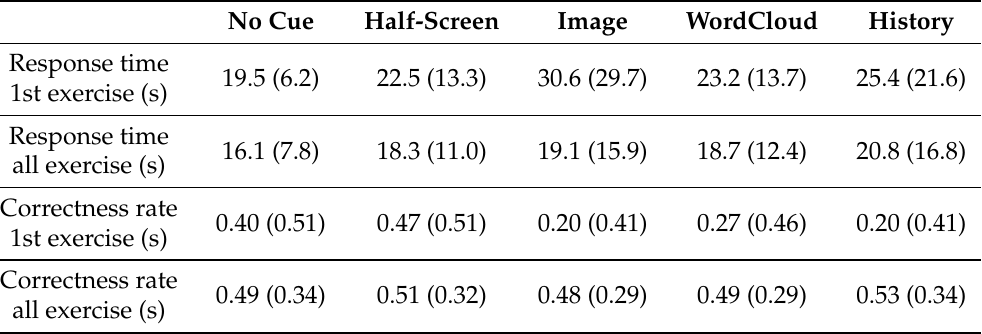
Figure 6. Effects of interruptions on ( a ) answer duration and ( b ) correctness rate. Asterisks indicate all statistically significant differences (* < 0.05| ** < 0.01). Table 1. Response time and correctness rate with different cues for the first or all exercises after an